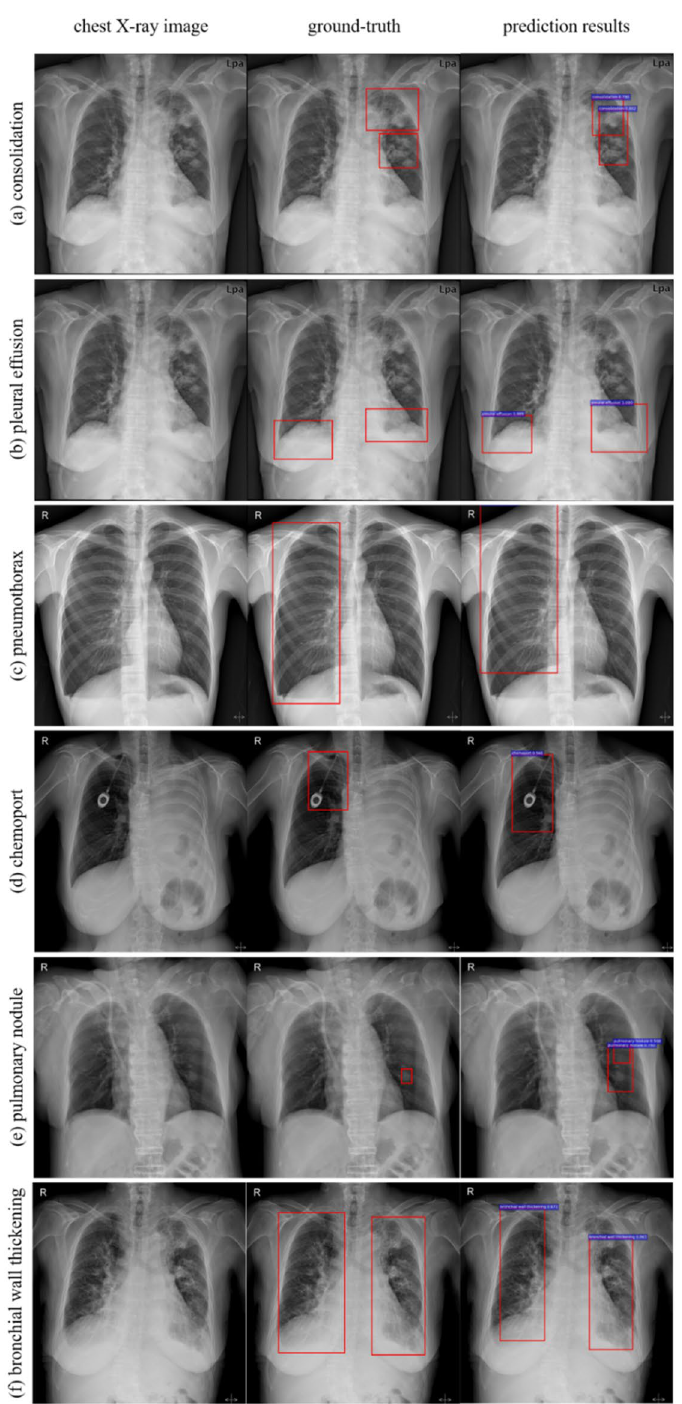
Figure 4. Examples of prediction results of multi-object detection in this study. Examples of the predicted results are shown in Figure 4. Overall, twelve classes are described in this model, such as pleural effusion, atelectasis, pulmonary nodule, cardiomegaly, consolidation, emphysema, pneumothorax, chemo-port, bronchial wall thickening, reticular opacity, pleural thickening, and bronchiectasis. From left to right, actual chest X-ray image, ground-truth (expert-described data labels), and results from prediction model are